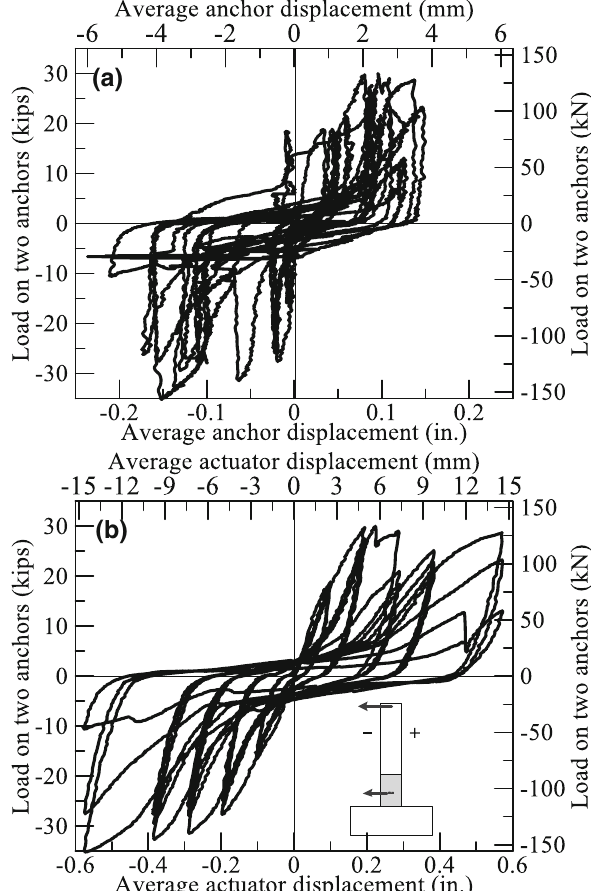
Fig. 8 Behavior of single anchor in plastic hinge zone under monotonic shear loading. a Comparison of measur- ments from two LVDT’s and b load vs average displacement curve.